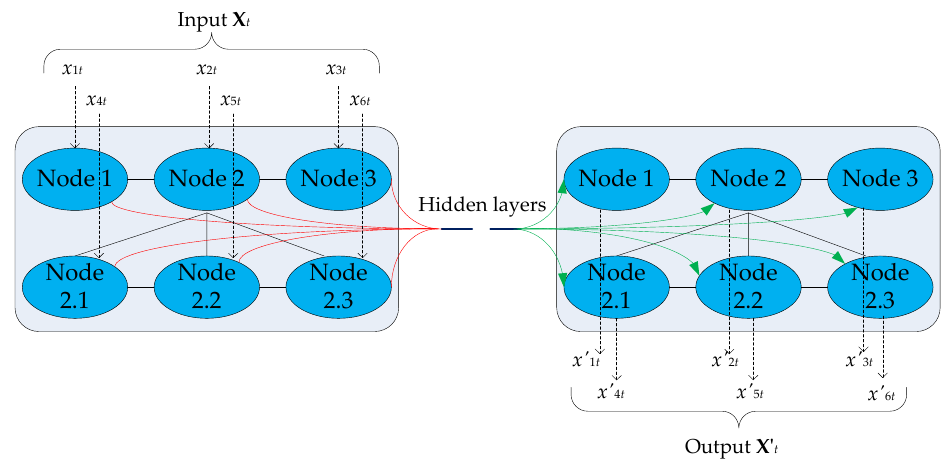
Figure 3. The schematic depiction of GCN for energy consumption prediction.